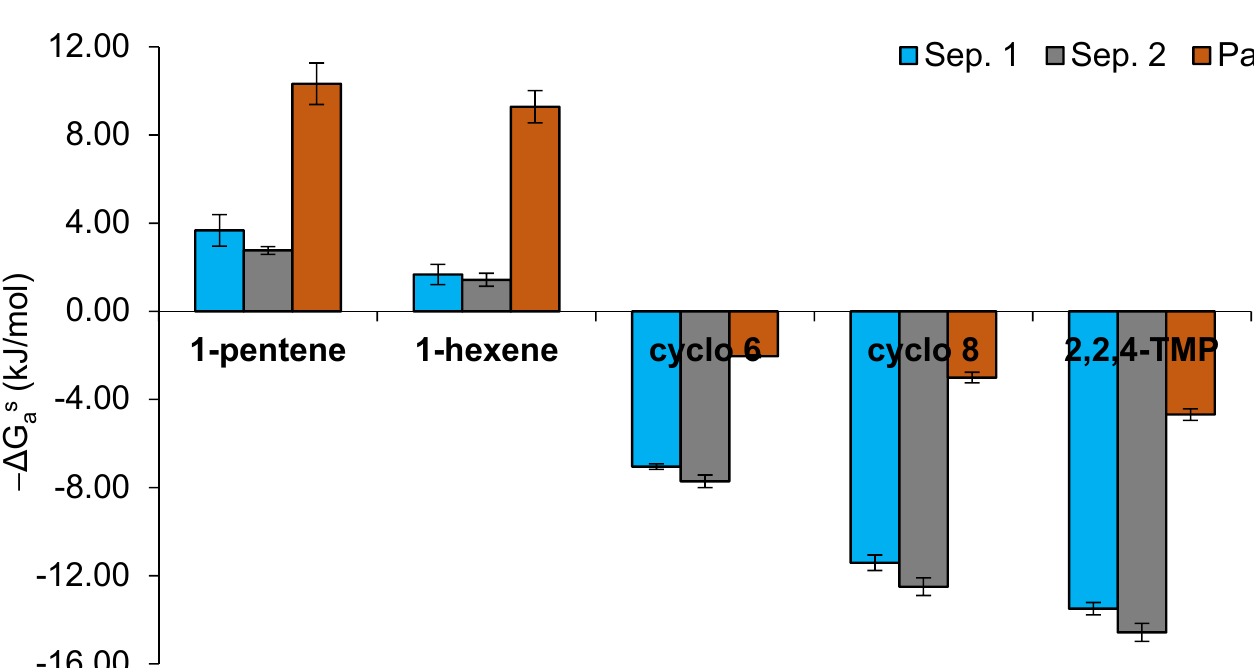
Figure 3. Specific interaction parameter ( − ∆ G as , kJ mol − 1 ) for the adsorption of 1-alkenes (1-pentene and 1-hexene), cycloalkanes (cyclohexane (cyclo 6) and cyclooctane (cyclo 8)), and a branched alkane (2,2,4-trimethylpentane (2,2,4-TMP)) on the surface of sepiolite and palygorskite samples at 240 °C.